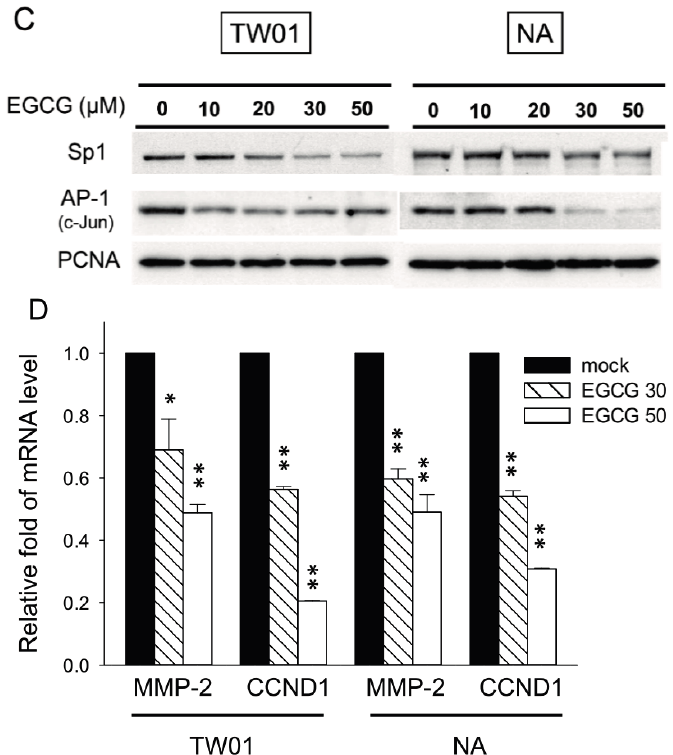
Figure 4. EGCG suppresses MMP-2 and MMP-9 activity through regulating the ERK signaling pathways. NPC cells were treated with various concentrations of